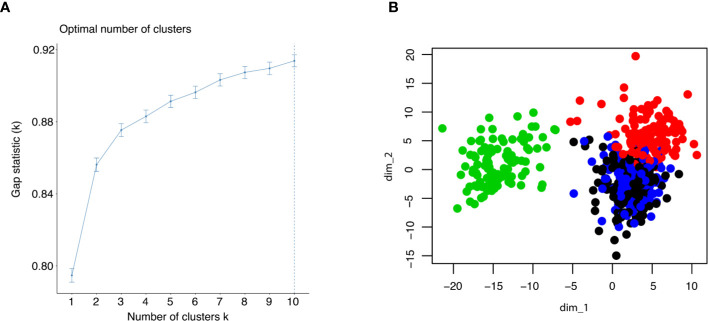

(A) Gap statistic was shown up to 10 clusters to determine the optimal k for k means clustering. (B) The result of k means clustering was plotted for k = 4, using all individuals.